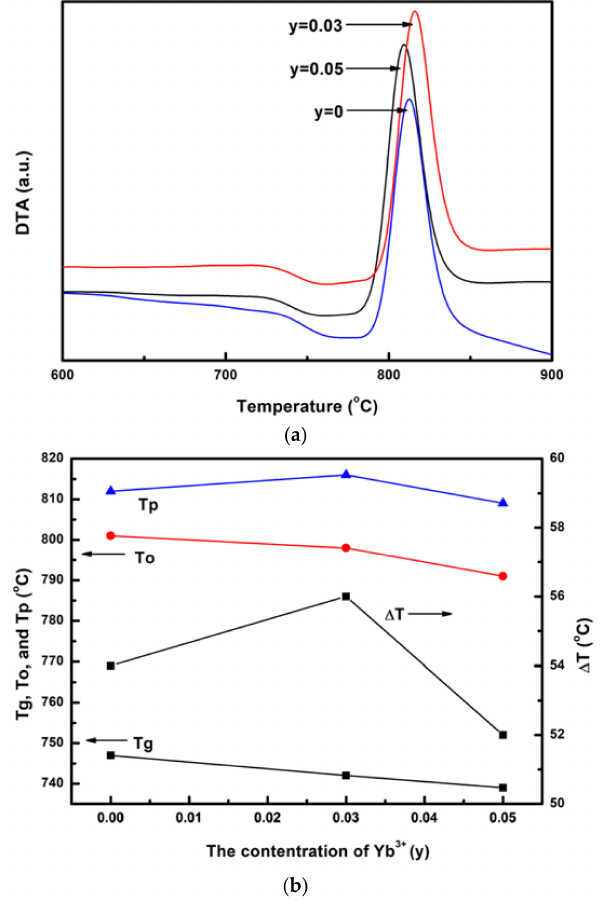
Figure 1. ( a ) Differential Thermal Analysis (DTA) curves of Tm 3+ /Yb 3+ co-doped La 2 O 3 -Nb 2 O 5 -Ta 2 O 5 (LNT) glasses with different contents of Yb 3+ ions; ( b ) The relationship between the values of T g , T o , T p , ∆ T, and Yb 3+